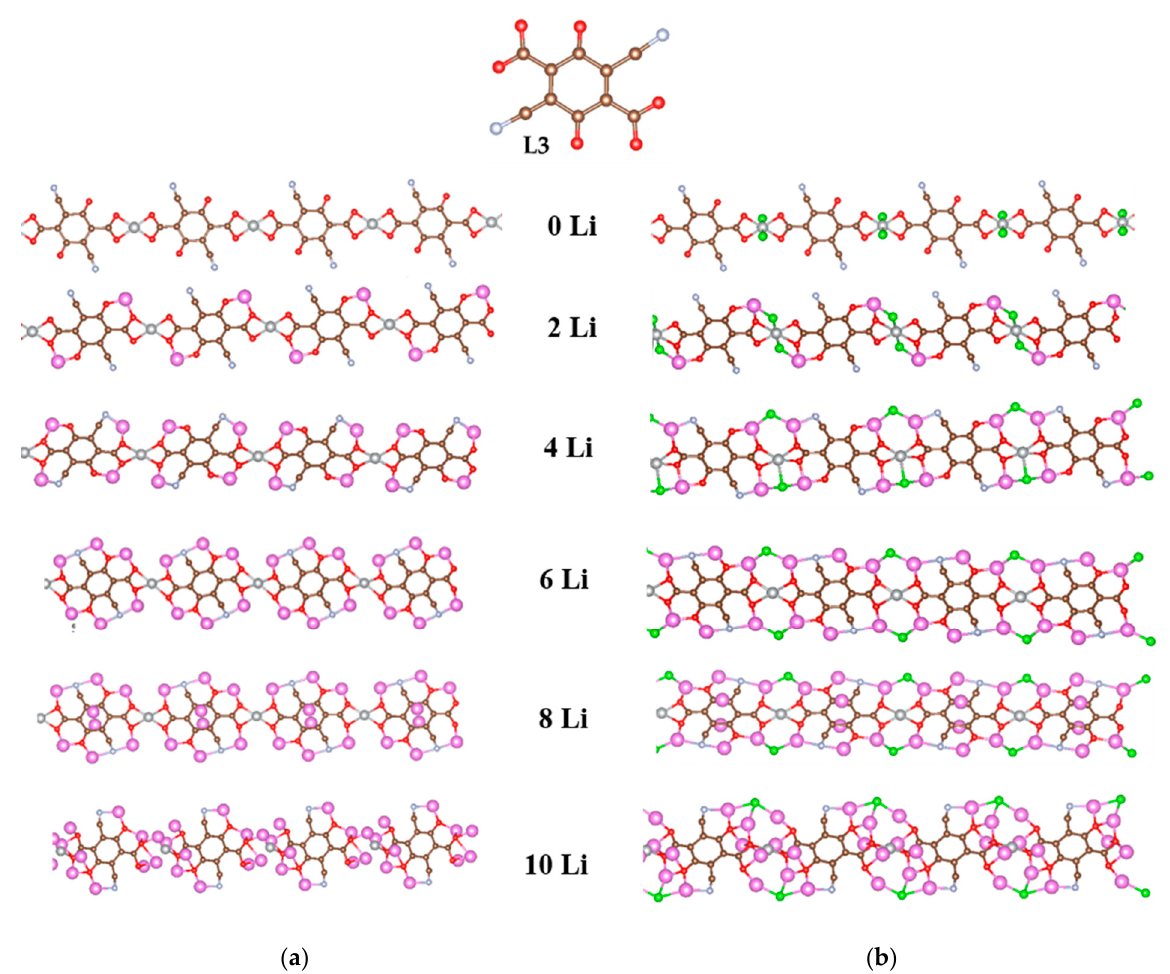
Figure 11. Optimized geometries of the step-by-step lithiated coordination polymers of ( a ) Ni(II) and ( b ) Ni(IV) with 2,5-dicarboxylato-3,6-dicyano-1,4-benzoquinone (L3). Color code: C—brown, H—white, O—red, Ni –gray-large, N—light blue-gray-small, Cl—green, Li—pink. Table 4. Repeating unit length (l eu ) of the polymers with L3 upon